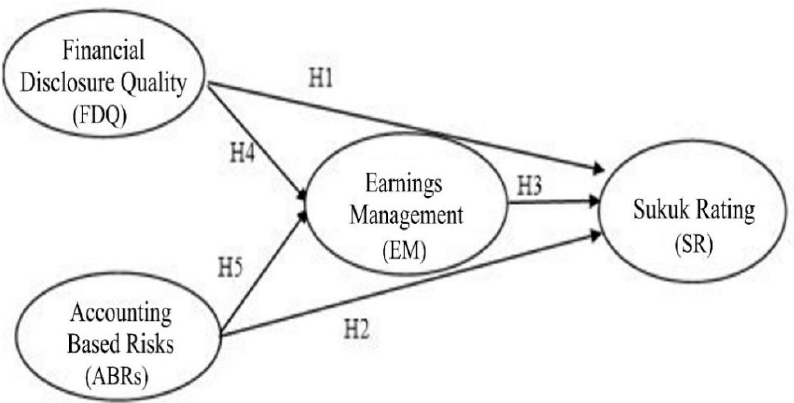
Figure 2. Theoretical Framework: Determinant of Sukuk Rating with Earnings Management as an Intervening Variable.